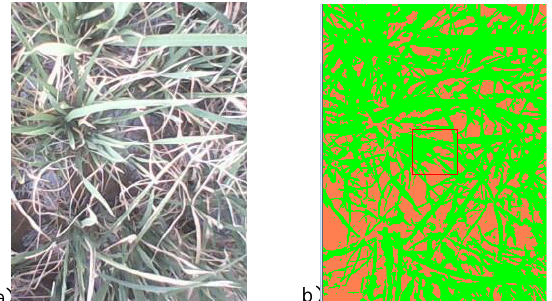
Figure 10: f-cover value estimation from the RGB image of healthy sample in its flowering stage; a)RGB image, b)classified image.